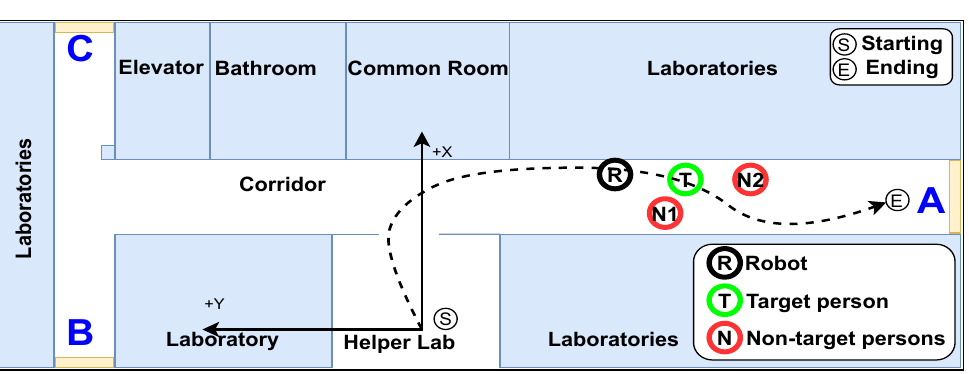
Figure 9. Realistic scenario of the robot and people in the